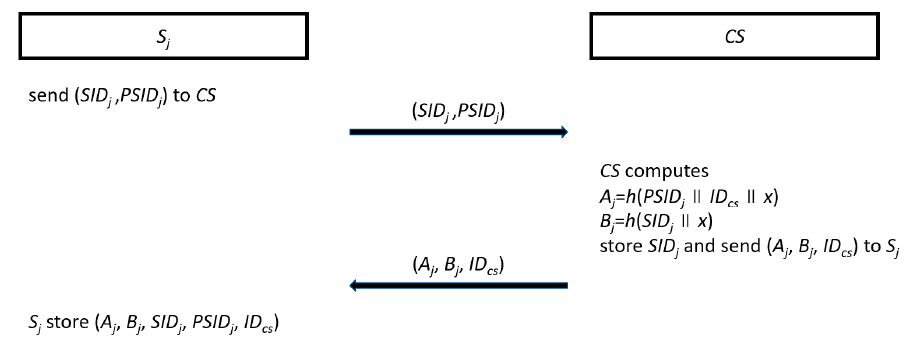
Figure 2. The flowchart of the cloud server registration